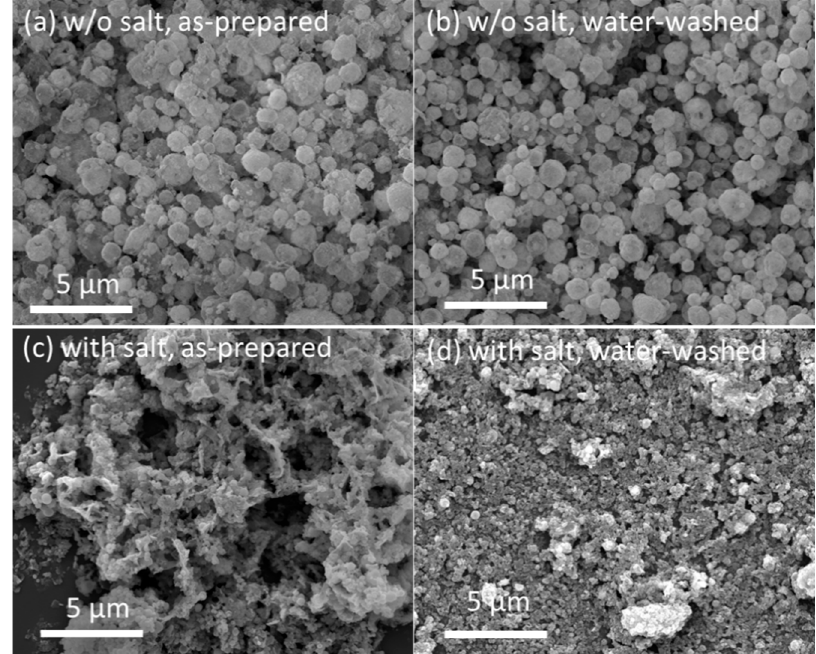
Figure 3. SEM images of: ( a ) as-prepared FSP product without sodium salts; ( b ) FSP product without sodium salts after washing with water; ( c ) as-prepared FSP product with sodium salts; and ( d ) FSP product with sodium salts after washing with water.